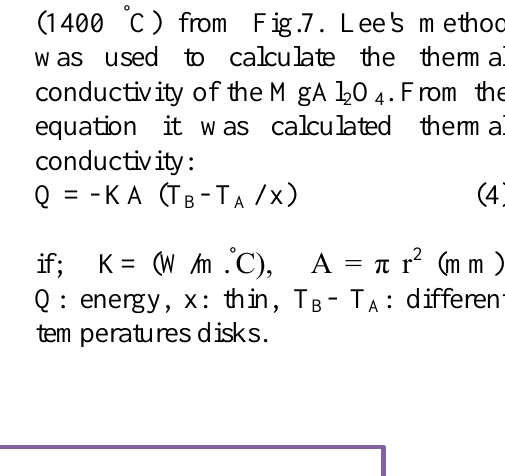
) at firing (1200 and 1400 °C) 2